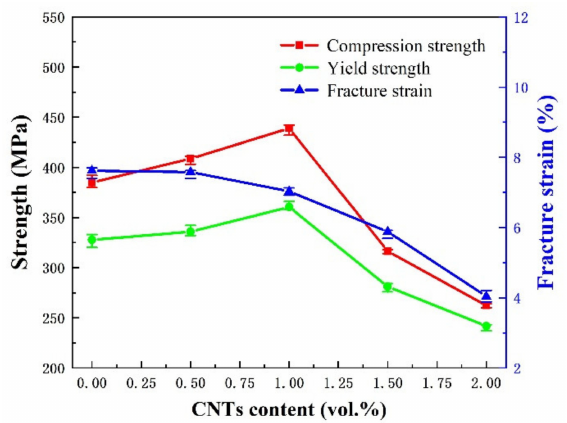
Figure 7. The variation curves of compressive strength, yield strength and fracture strain with different CNT contents in